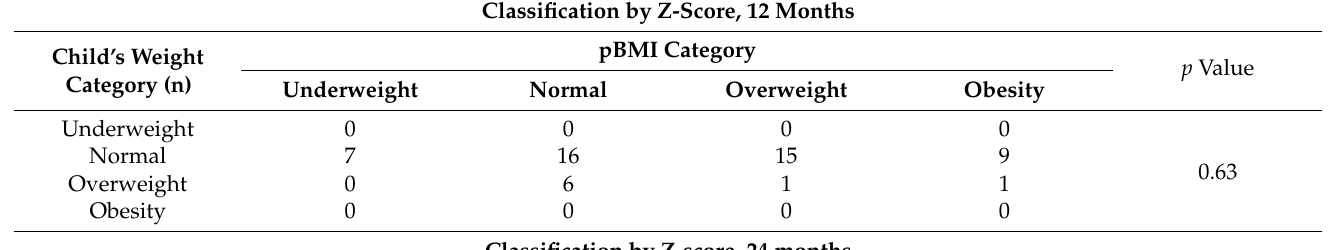
Table 3. Occurrence of abnormal body weight in children according to the pBMI category. Classification by Z-Score, 12 Months